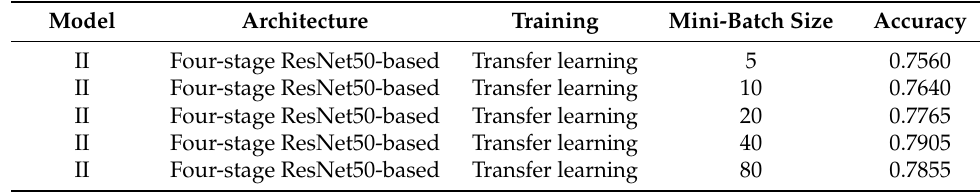
Table 3. Comparison of different mini-batch sizes.